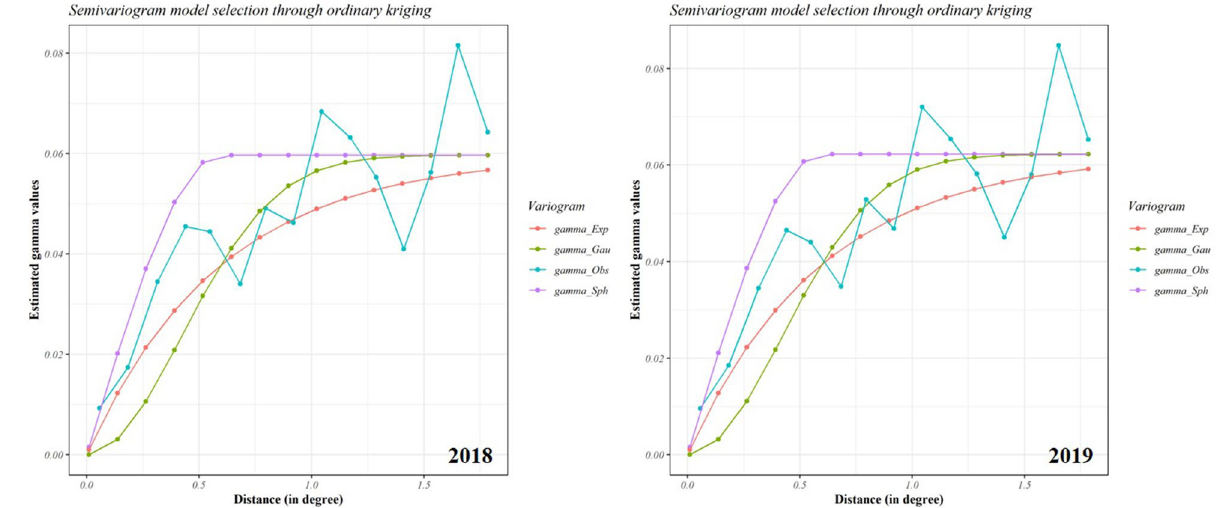
Figure 8. Semivariogram of different experimental models for rice blast disease severity during 2018 and 2019. The colored lines depict the different models such as spherical (purple), exponential (red), and Gaussian (green) models that depict the spatial autocorrelation of measured sample points. Blueline indicates the observed values.